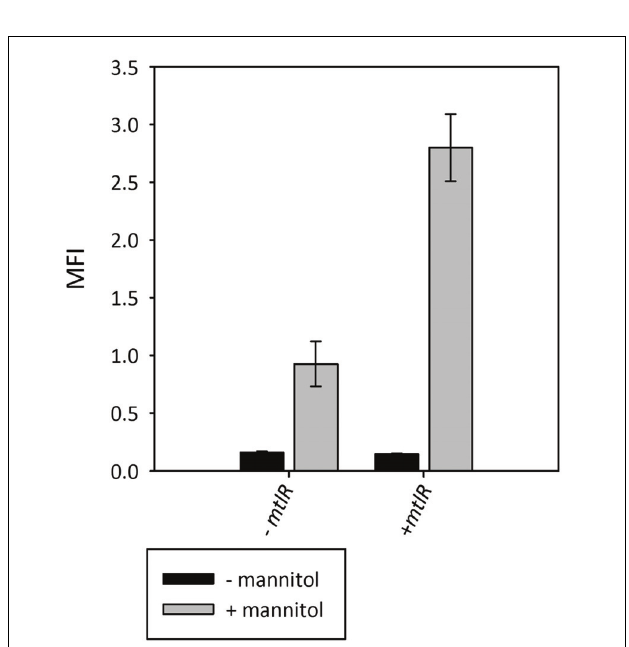
FIGURE 7 | Effect of plasmid-borne overexpression of mtlR on mannitol-inducible gfpuv reporter gene expression from mtlR promoter variant m2p. MFI − median fluorescence intensity of GFPuv given in a.u. GFPuv fluorescence of exponentially growing cells was measured after 2 h incubation at 37 ◦ C and 200 rpm. Mean values and standard deviations of triplicate shake flask cultures are given.